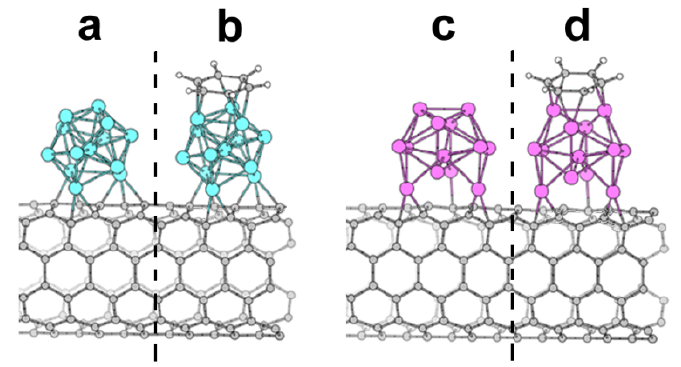
Figure 5. Structure of Ni the recognition of benzene by these